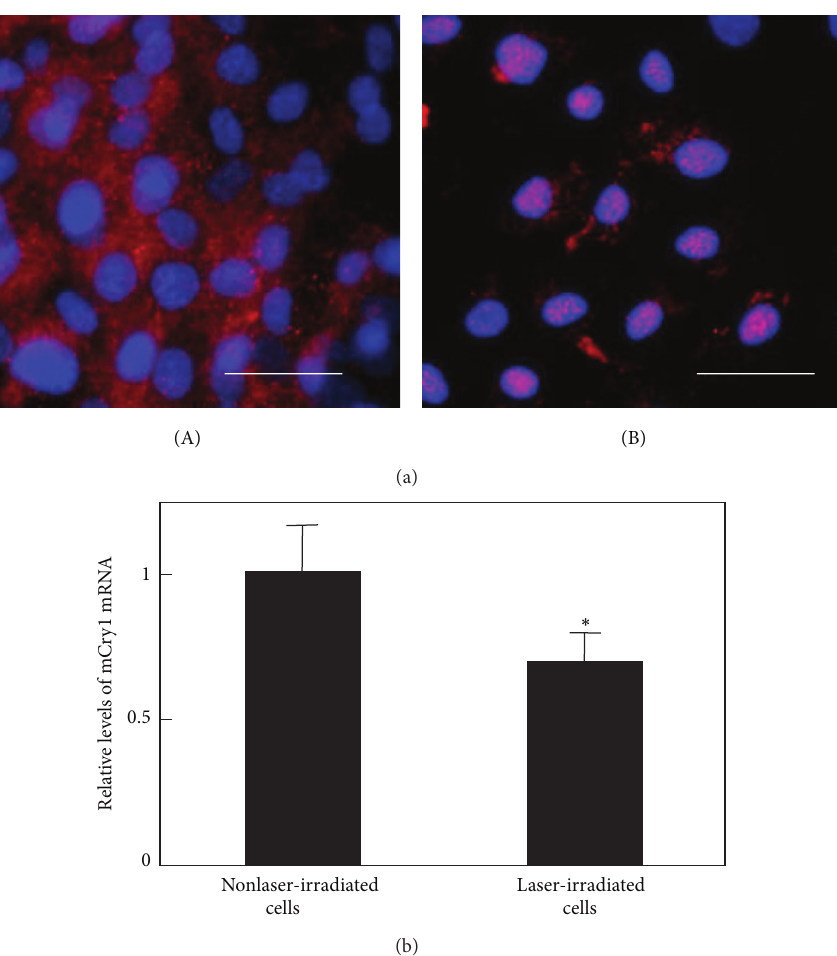
Figure 2: (a) Subcellular location of CRY1 proteins in MSCs after laser irradiation (200 mW/cm 2 ). Cells were double-labeled with DAPI (blue) and CRY1 (red). CRY1 localized to the cytoplasm prior to laser irradiation (A). However, after laser irradiation, CRY1 translocated to the nucleus (B) (scale bars: 50 𝜇 m). (b) mRNA levels of Cry1 in MSCs 24 h after laser irradiation (200 mW/cm 2 ) and in nonirradiated cells. Samples were normalized to mRsp18. The mRNA levels of Cry1 decreased after blue laser irradiation relative to nonirradiated cells ( ∗ 𝑃 < 0.01 , indicating significant difference between the relative mRNA levels of laser-irradiated MSCs and controls)